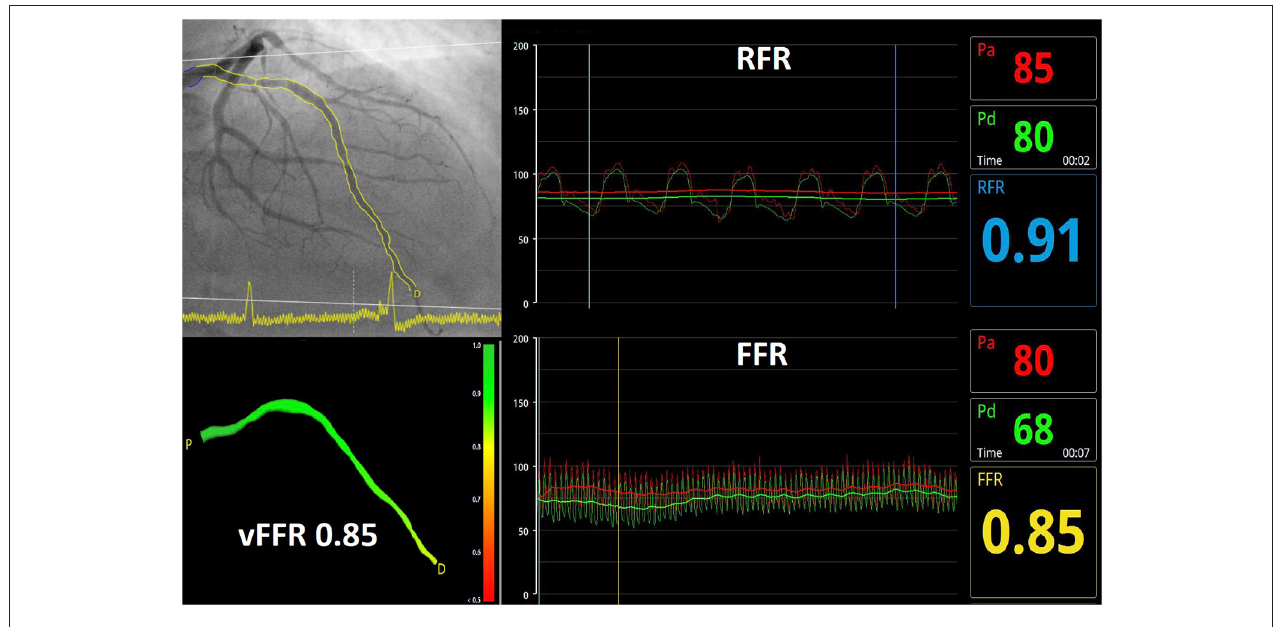
FIGURE 1 | Illustration of a vFFR analysis.